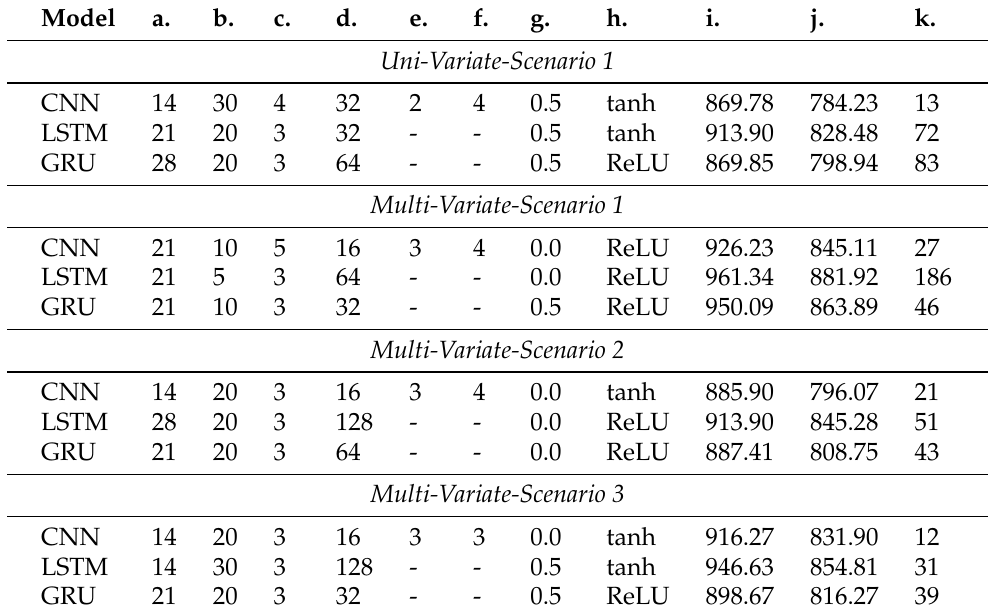
Table 8. Best results, per scenario, for Method 2. The letters stand as follows: a. timesteps; b. batch size; c. number of layers; d. number of neurons/filters; e. pool size; f. kernel size; g. dropout; h.